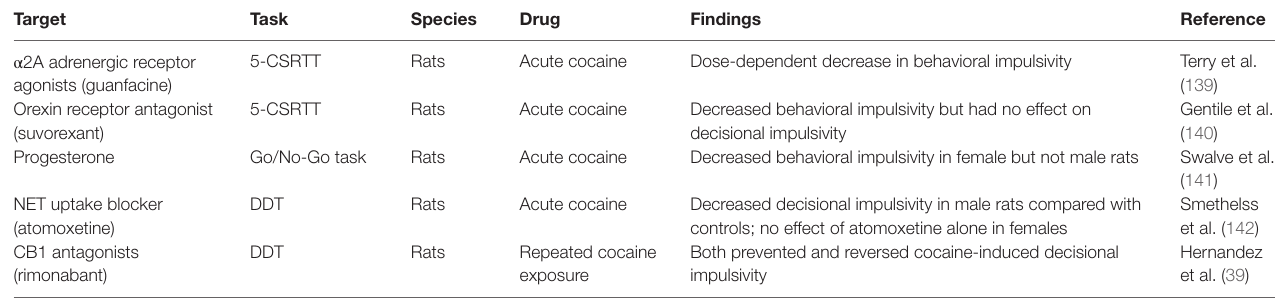
TABLE 2 | Pharmacological alleviation of psychostimulant-induced impulsivity in